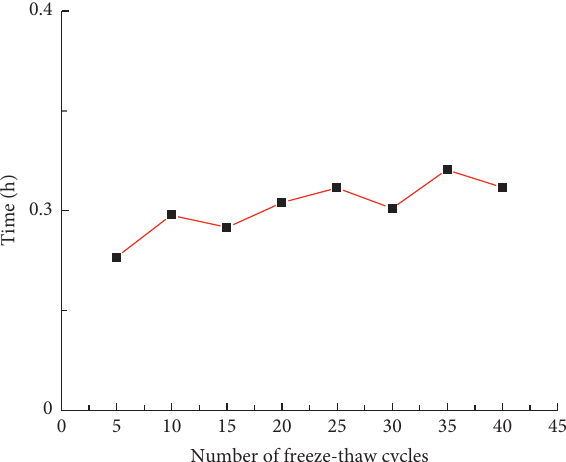
Figure 10: Variations in the time required for the water-ice phase change with the number of freeze-thaw